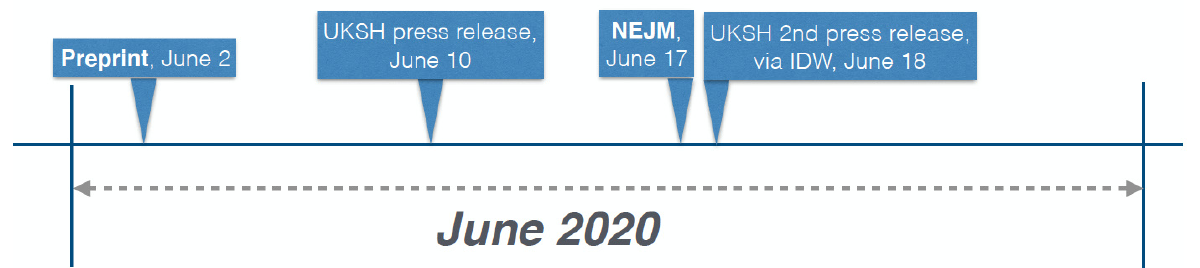
Figure 2. Timeline showing dates of preprint, press releases, and publication of the paper in New England Journal of Medicine. NEJM: New England Journal of Medicine. UKSH: Universitätsklinikum Schleswig-Holstein, Germany.